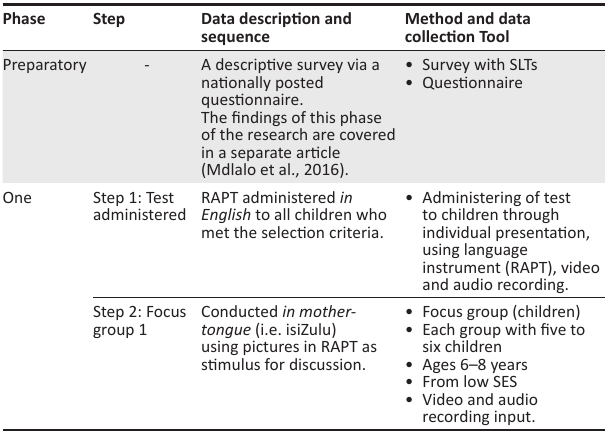
TABLE 1: The research data description and data collection